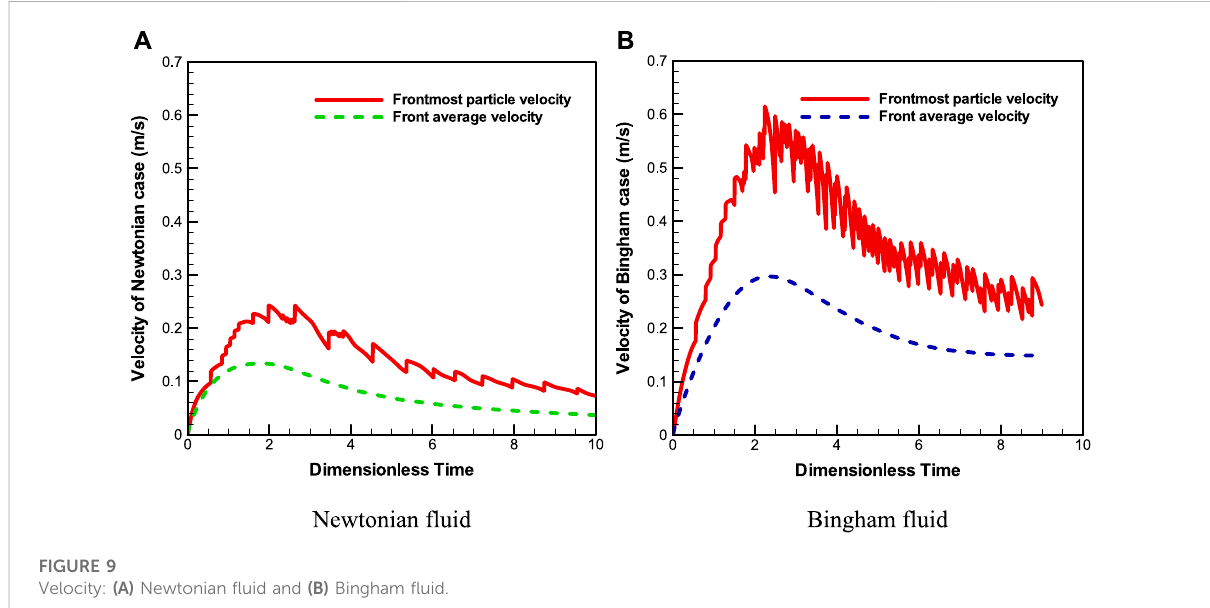
FIGURE 9 Velocity: (A) Newtonian fl uid and (B) Bingham fl